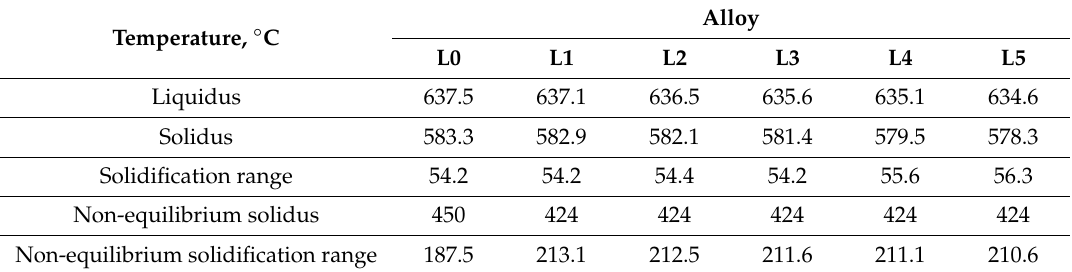
Table 2. Calculated critical solidification temperatures of the experimental alloys.